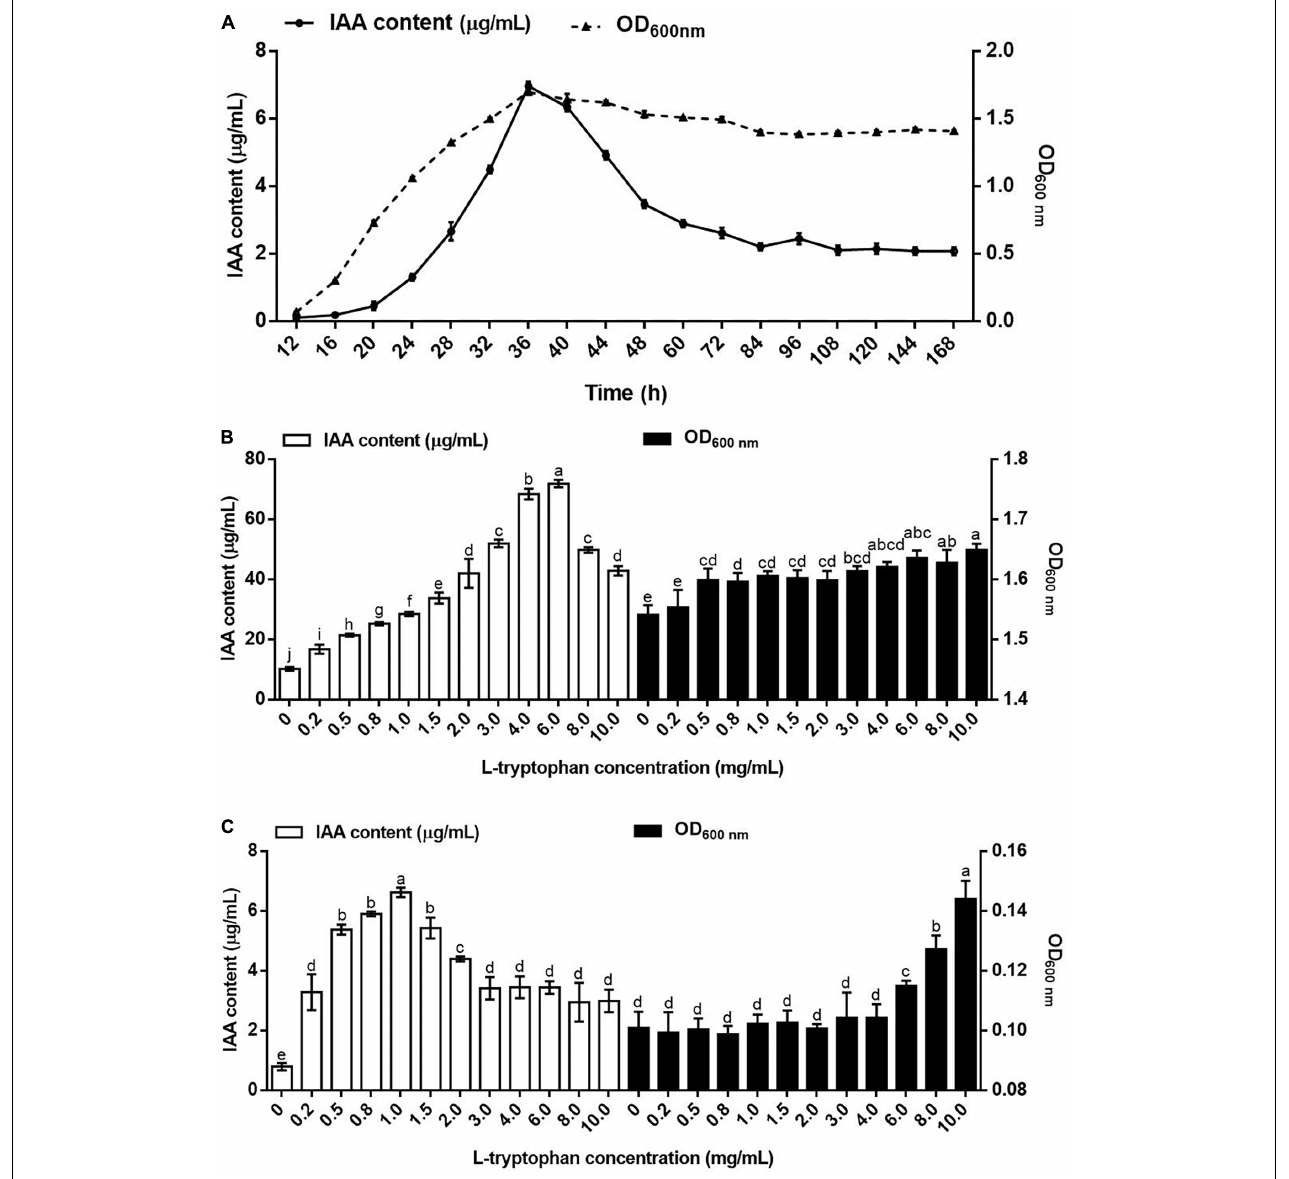
FIGURE 1 | Indole-3-acetic acid in B. pyrrocinia JK-SH007. (A) Relationship between the growth of B. pyrrocinia JK-SH007 and IAA biosynthesis. (B) Effects of L-Trp on the synthesis of IAA by B. pyrrocinia JK-SH007 in TSB liquid medium. (C) Effects of L-Trp on the synthesis of IAA by B. pyrrocinia JK-SH007 in SD liquid medium. The error bars represent the SDs, and different letters indicate significant